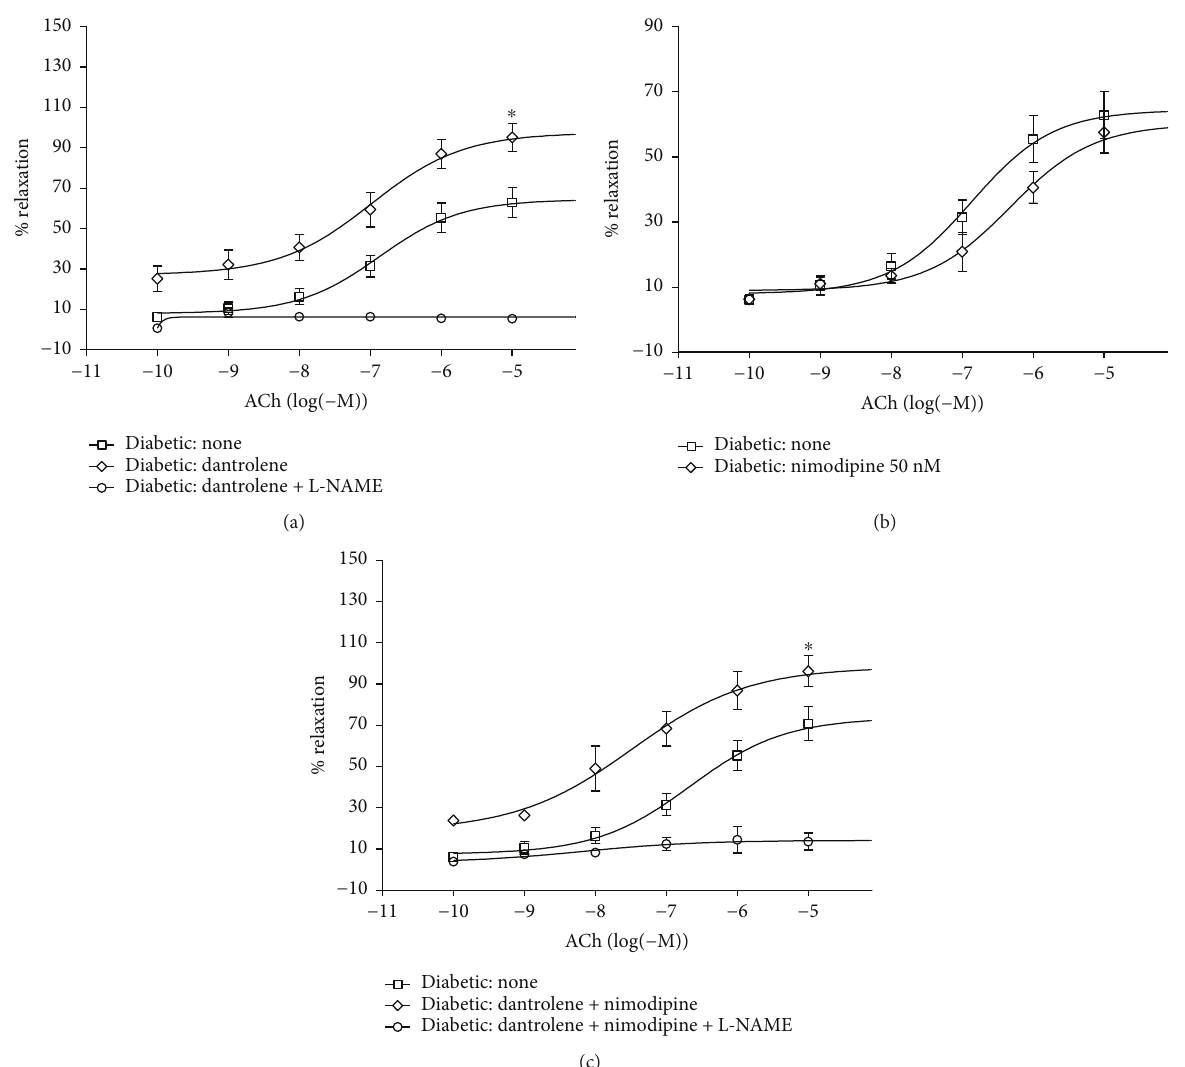
Figure 4: Cumulative concentration-response curves for the acetylcholine- (ACh-) induced relaxation of aortic rings from STZ diabetic rats after a 30min incubation period with 50 μ M dantrolene (a), with 50nM nimodipine (b), and with both drugs in combination (c). Aortic rings were precontracted with 0.1 μ M phenylephrine (PHE) before the addition of cumulative concentrations of ACh. The values shown are the means ± SEM of 6 to 9 animals per group. Note that the addition of 1mM L-NAME to the incubation bath inhibited the ACh-induced relaxation of aortic rings from dantrolene and dantrolene+nimodipine-treated diabetic rats. ∗ P < 0 05 , when comparing E after incubation with dantrolene and with dantrolene and nimodipine in